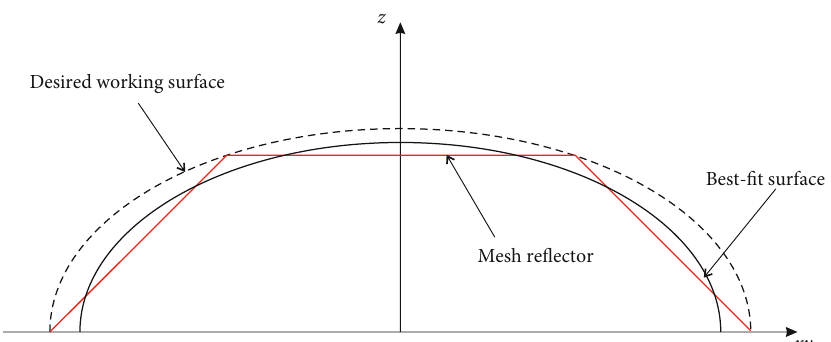
Figure 6: Schematic of the best- fi t surface and desired working surface of a DMR.